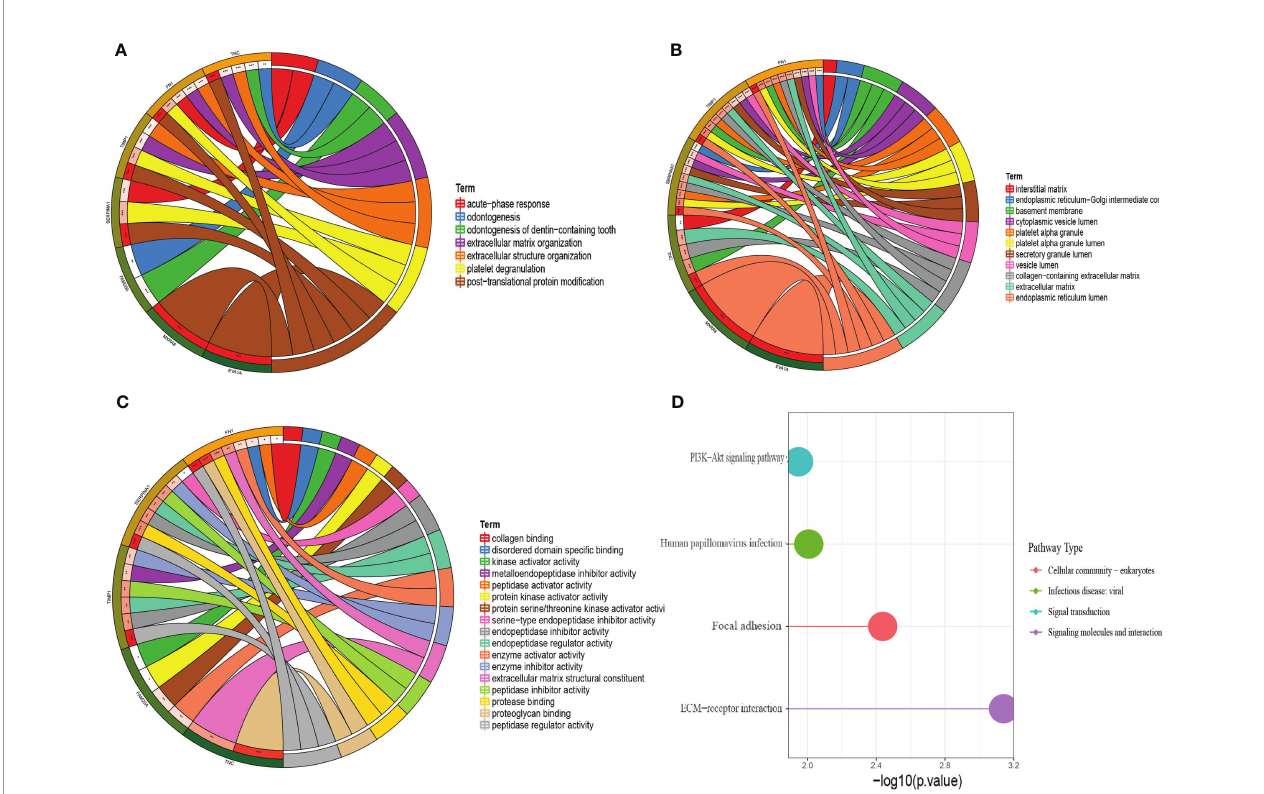
FIGURE 4 | GO analysis and KEGG analysis of the seven hub genes. (A) Circle plot of BP analysis. (B) Circle plot of CC analysis. (C) Circle plot of MF analysis. (D) KEGG